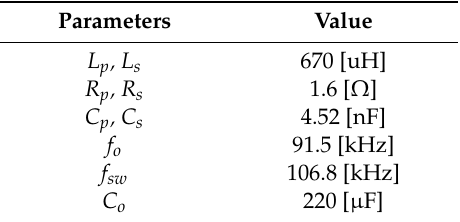
Table 2. Parameters for experiments.